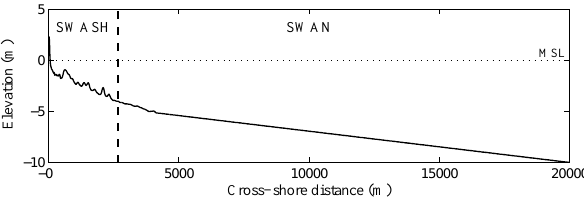
Figure 5. Beach profile at Dzilam showing the section correspond- ing to simulations performed by the SWAN model (10–4m depth) and the section for SWASH simulations (4m depth to shore). Dotted line represents the mean sea